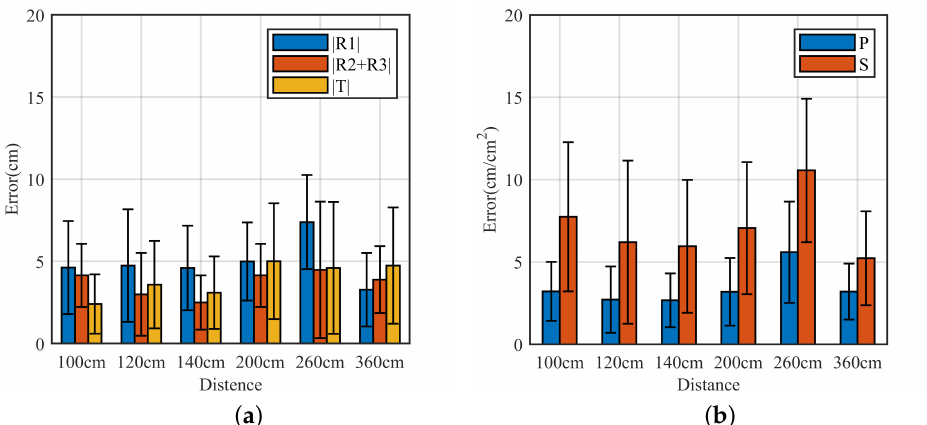
Figure 12. MAL positioning error. ( a ) Vertical distance error. ( b ) MAL model perceived area and half perimeter